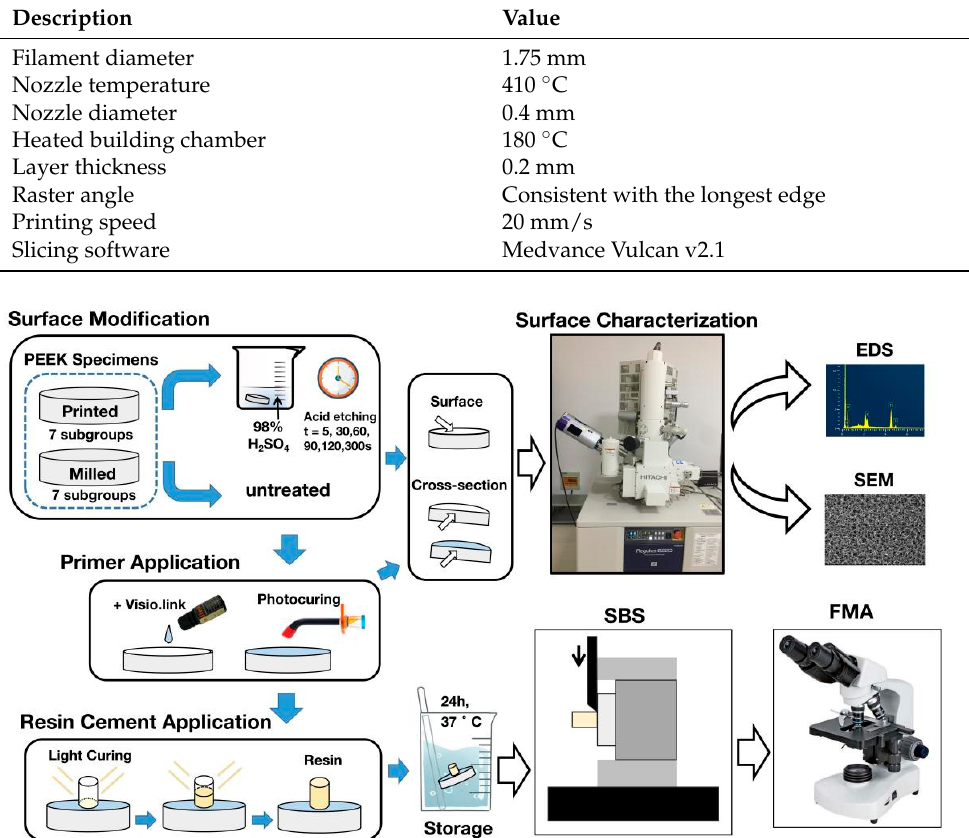
Figure 1. The diagram showing the workflow in this study. The surface modification indicates the pretreatment of PEEK. The surface characterization indicates microscopic morphology observation and surface elemental compositions analysis of PEEK. EDS, energy-dispersive spectrometer. SEM, scanning electron microscope. SBS, shear bond strength tests. FMA, failure modes analysis.